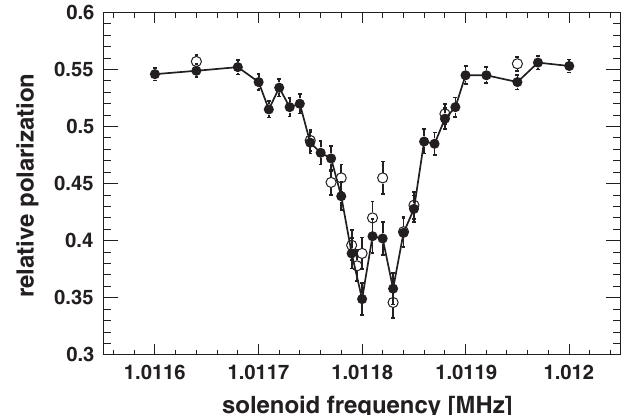
FIG. 2. Mean Schottky power spectrum extracted from mea- FIG. 3. Spin-resonance measurements at one energy (closed surements over five days at one energy. The statistical error bars circles). The cycle timings are described in Table I. The open lie within the data points. By calculating the weighted arithmetic (cid:3) f 0 ¼ 1 403 831 : 75 (cid:4) symbols represent results obtained for an extended cycle time, mean, an average revolution frequency of 0 : 12 Hz was deduced. where the perturbing solenoid was switched on after 178